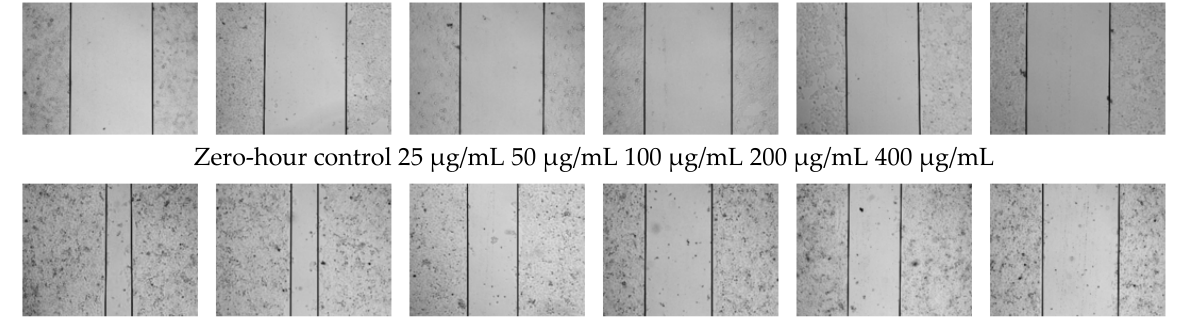
Figure 7. Effect of OF/PVP/PVA hydrogels on migration of CAL-27 cell scratching assay was performed. The area of scratch was observed under a microscope (×10).